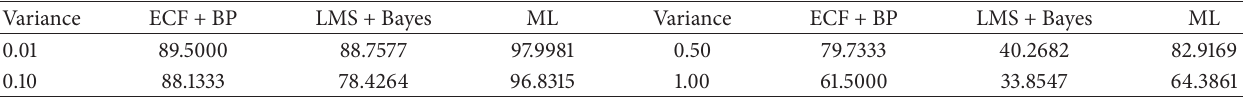
Table 7: Classification accuracy rates using other algorithms under different